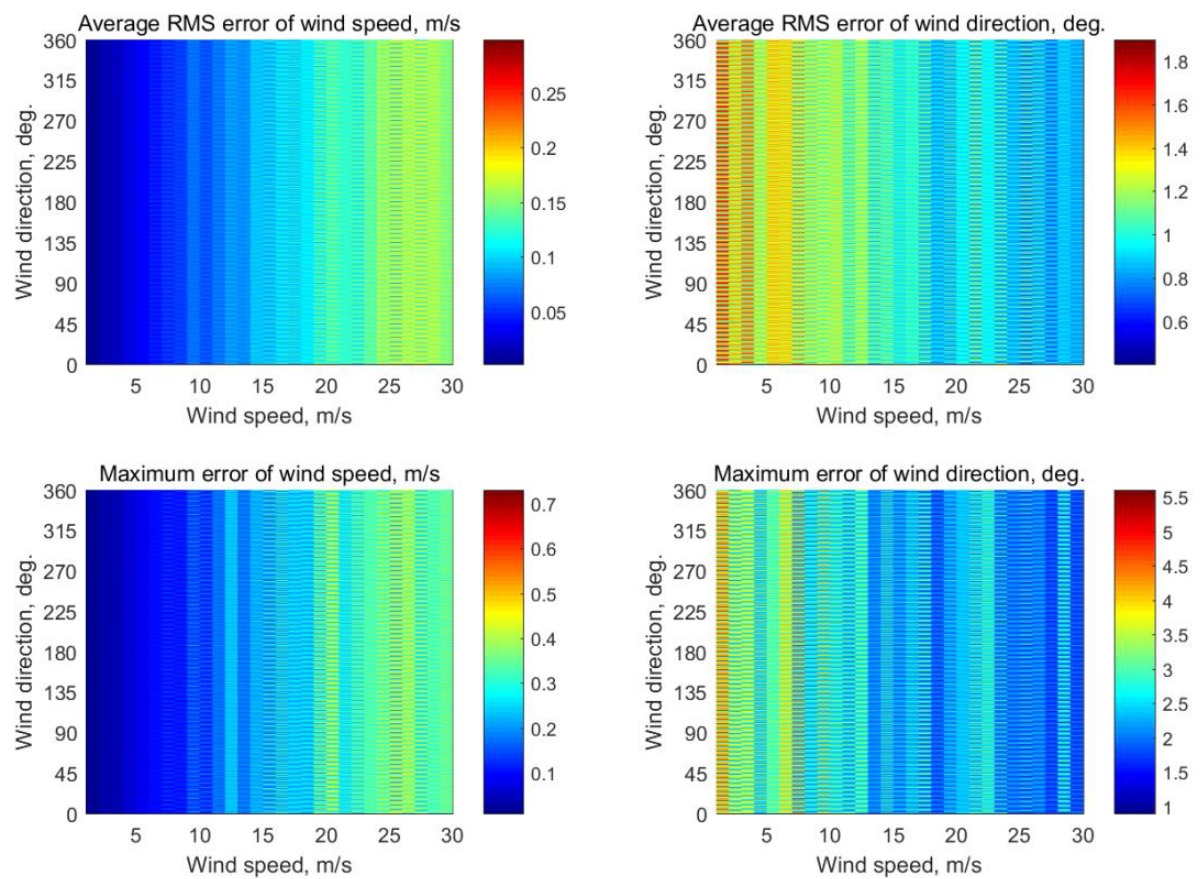
Figure A23. Simulation results of the use of seven incidence angles of 30°, 35°, 40°, 45°, 50°, 55°, and 60° for wind retrieval.